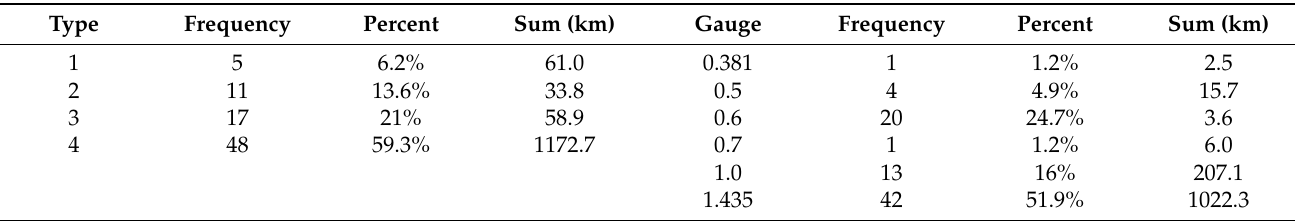
Table 1. Statistics of the railway classification.